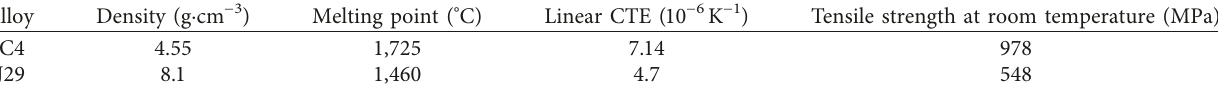
Table 2: Physical properties of base metals.